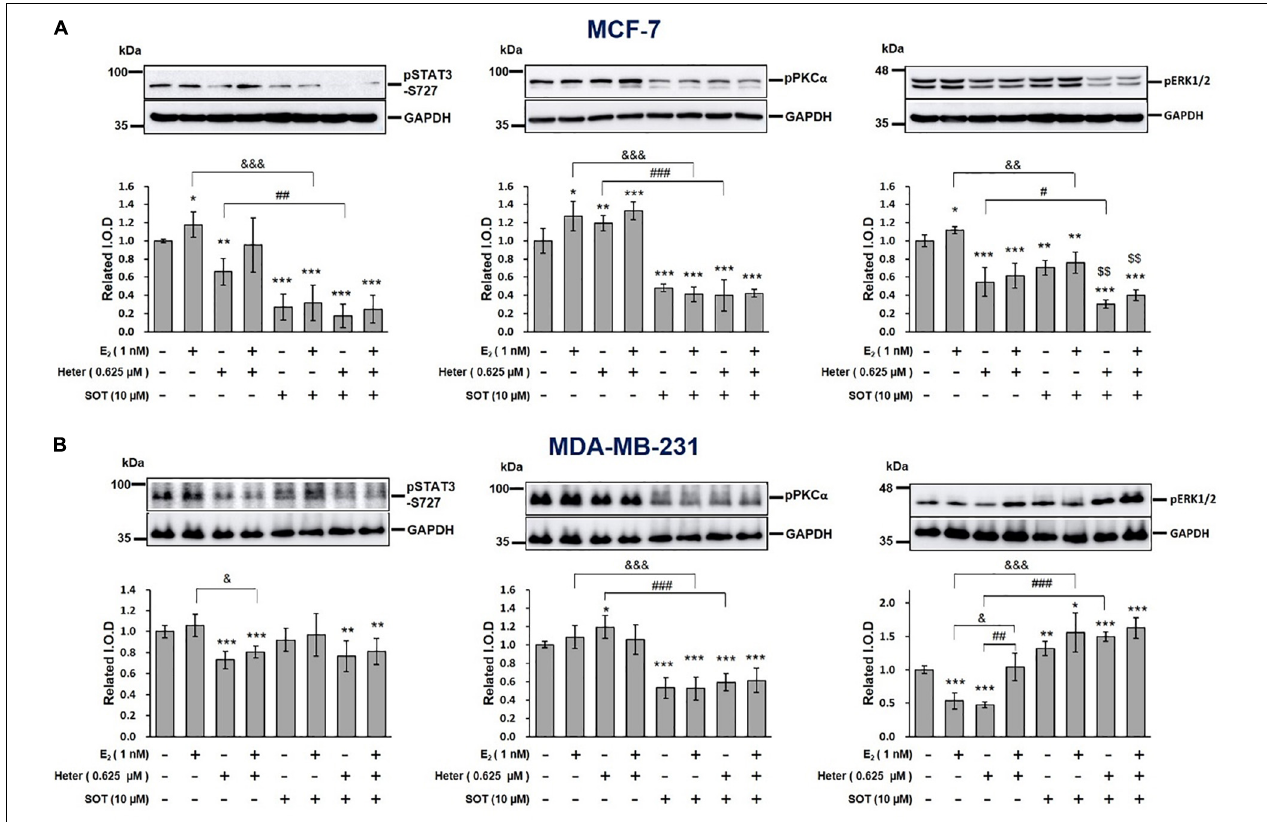
FIGURE 4 | Estrogen, heteronemin, and sotrastaurin (SOT) affect the signal transduction pathway in breast cancer cells. (A) MCF-7 and (B) MDA-MB-231 cells were treated with 1 nM E 2 , 0.625 µ M heteronemin, and their combination in the presence and absence of the PKC inhibitor, SOT for 24 h. Cells were harvested and total proteins were extracted. Western blot analyses were conducted for phosphorylated (p)STAT3, pPKC α , and pERK1/2. The number of independent studies ( n ) = 4. * p < 0.05, ** p < 0.01, *** p < 0.001, compared to the untreated control. # p < 0.05, ## p < 0.01, ### p < 0.001 compared to heteronemin. & p < 0.05, && p < 0.01, &&& p < 0.001, compared to E 2